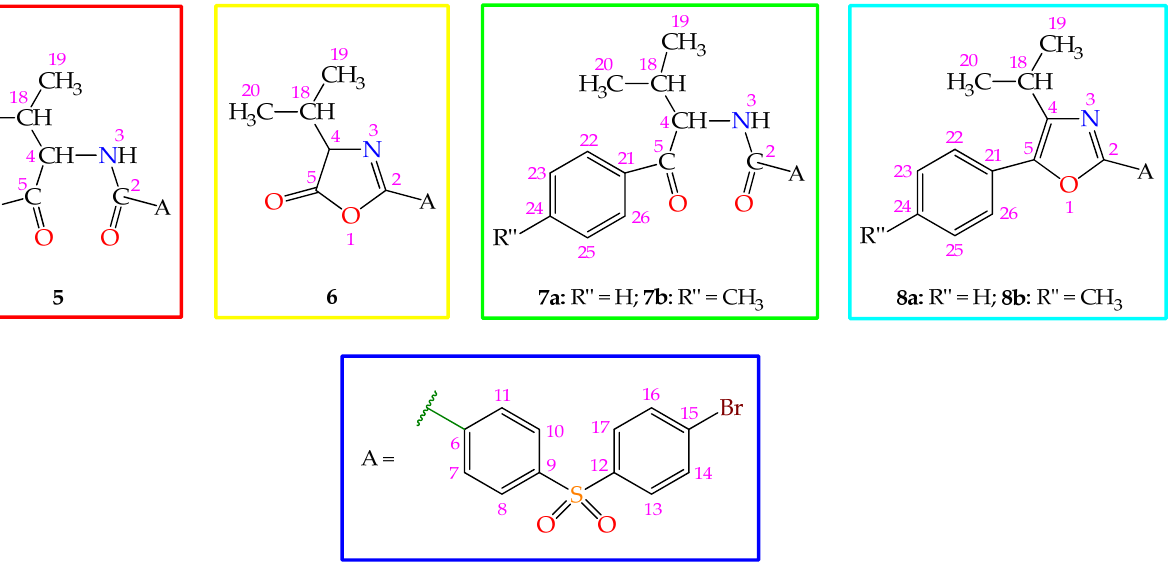
Figure 3. Molecular structures of the new 4-[(4-bromophenyl)sulfonyl]benzoic acid derivatives 5 – 8 with the atom numbering (for assigning NMR signals).